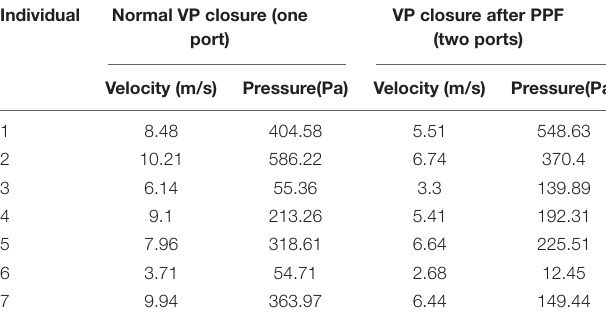
The difference between one-port and two-port structures was found in individual 4 ( Figures 3Dd , 4Dd